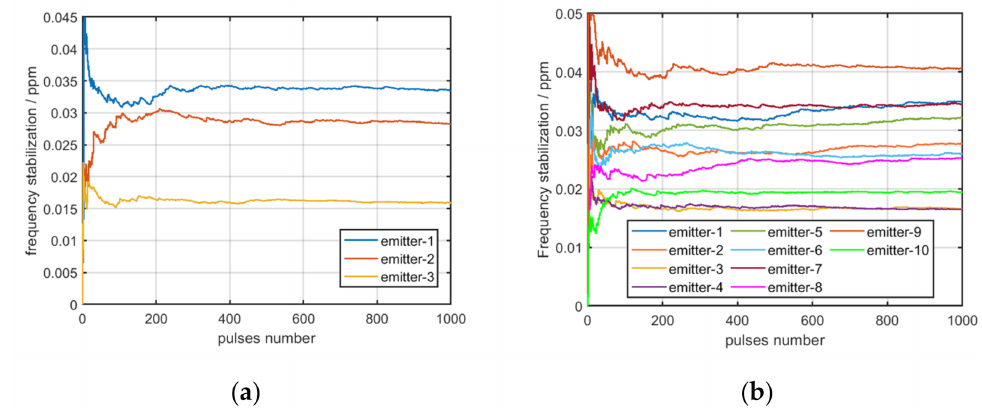
Figure 5. ( a ) Frequency stabilization of three emitters; ( b ) frequency stabilization of ten distinct emitters; the x-axis represents the number of pulses used to calculate the standard deviation of the frequency, and the y-axis represents the value of frequency stabilization.